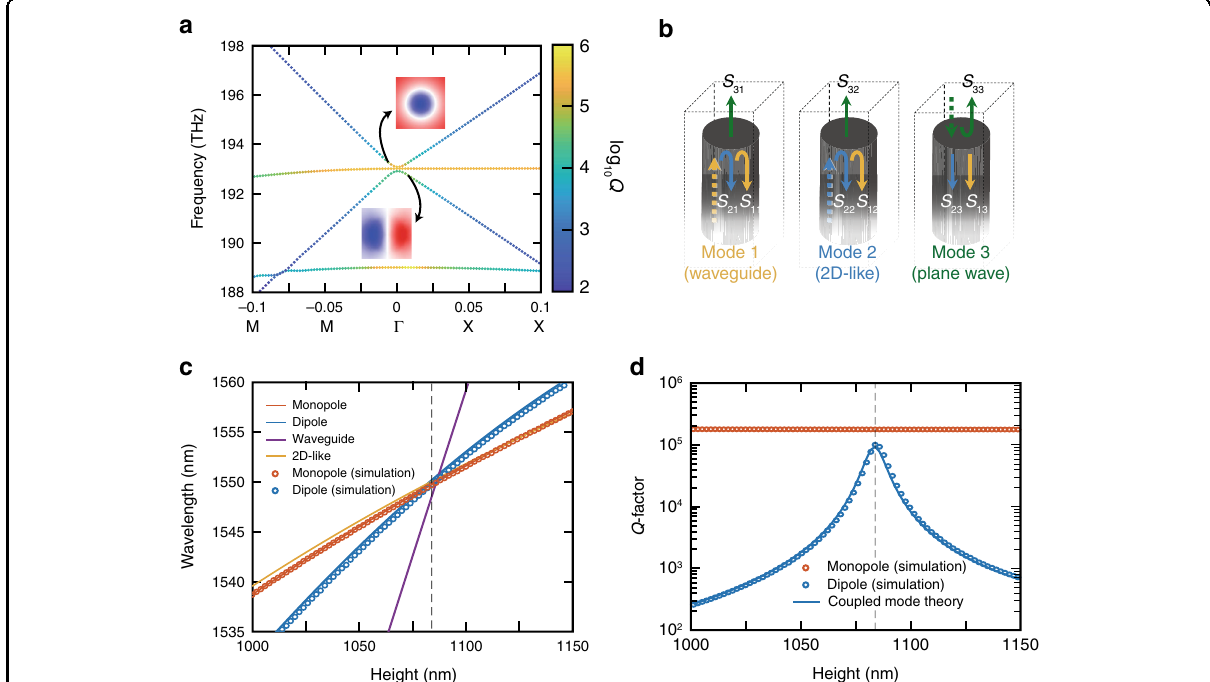
Fig. 3 Mechanism of coupled mode theory and performance of the zero-index material calculated by both Lumerical FDTD and CMT. a Band structure of a zero-index PhC slab without BICs. The colormap indicates the quality factor of different modes. In the vicinity of the Dirac point, the monopole mode shows a high quality factor, while the dipole mode shows a low quality factor. b At the facet of the PhC slab, the waveguide and 2D-like modes can both couple to plane waves in free space, forming a three-port network. c Resonant wavelengths for modes of fi nite pillar arrays of various heights. The effective wavelength (blue) of the waveguide resonance equals the monopole resonance at pillar height h = 1085 nm, where λ = 1550 nm, forming an impedance-matched zero-index mode. d Radiative quality factors for modes of fi nite pillar arrays of various heights. In this fi nite pillar array structure, the Q-factor of the dipole mode shows a maximum of over 10 5 near the BIC condition at h = 1085 nm, reducing the propagation loss